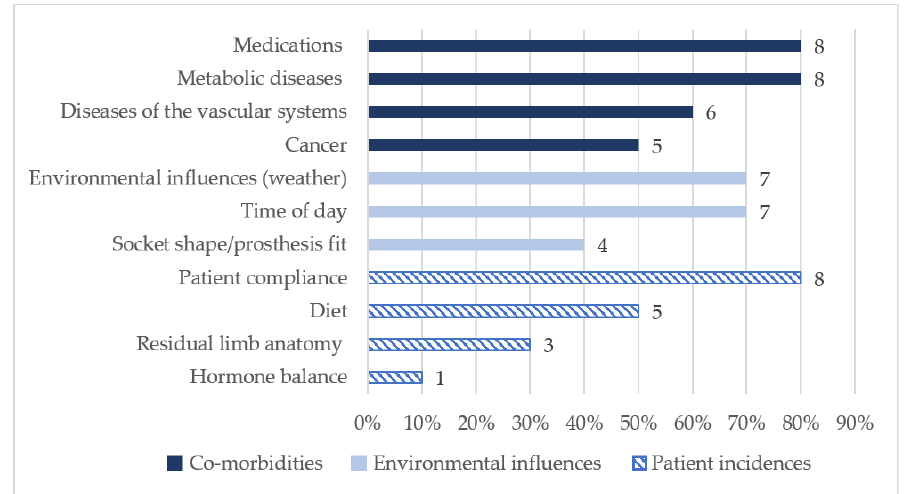
Figure 5 . Factors i nfluencing volume fluctuations. Figure 5. Factors influencing volume